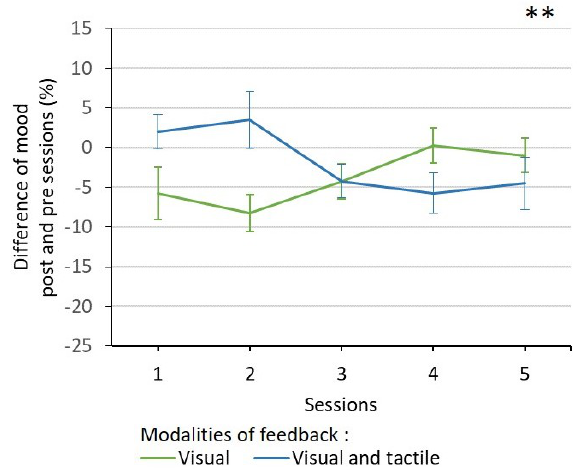
Figure 7. Evolution over the sessions of the positive mood between the end and the beginning of session depending on the modality of feedback. The double * on the top corner represents how significant the interaction “Modality*Session” represented in this Figure is, i.e., p ≤ 0.01. Mindfulness decreased significantly more over the session when participants were training with a visual feedback ( M = − 9.38, SD = 2.86) than when they were training with a multimodal feedback ( M = − 2.88, SD = 2.35). This is particularly visible during the first two sessions. During these sessions, the mindfulness increases between the beginning and the end of the session when the participants were training with multimodal feedback but greatly decreases when they were training with visual feedback. Overall, the mindfulness seems to decrease over the sessions when participants were training with a multimodal feedback whereas a large increase is visible between the third and the last sessions when participants were training with a visual feedback (see Figure 8).